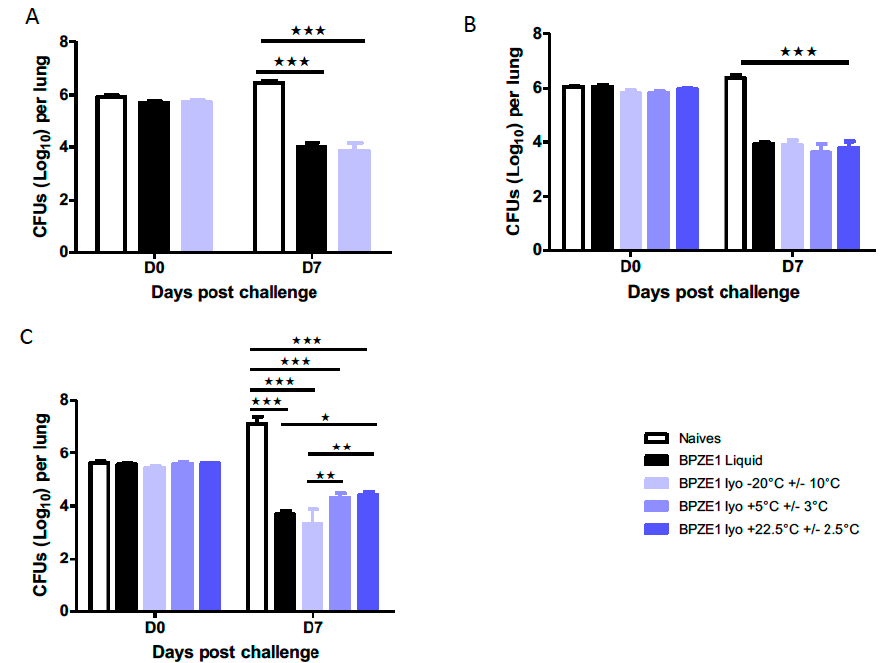
Figure 5. Potency of the lyophilized BPZE1 drug product compared to the liquid drug product. BALB / c mice (n = 5 per group and per time point) were intranasally vaccinated with 10 5 CFU of the liquid BPZE1 drug product (black bars) or the reconstituted lyophilized BPZE1 drug product (blue bars), or received PBS as a mock control (white bars). Four weeks later, the mice were challenged intranasally with 10 6 CFU of virulent BPBCTA1. CFU counts in the lungs were conducted 3 h (D0) and 7 days (D7) post-challenge. ( A ) Comparison of the potency of the liquid BPZE1 drug product with that of the lyophilized BPZE1 drug product reconstituted and administered immediately after lyophilization. ( B ) Comparison of potency of the liquid BPZE1 drug product with that of the lyophilized BPZE1 drug product reconstituted 6 months after storage at − 20 ◦ C ± 10 ◦ C (light blue lines), 5 ◦ C ± 3 ◦ C (middle blue lines) or 22.5 ◦ C ± 2.5 ◦ C (dark blue lines). ( C ) Comparison of the potency of the liquid BPZE1 drug product with that of the lyophilized BPZE1 drug product reconstituted 24 months after storage at − 20 ◦ C ± 10 ◦ C (light blue lines), 5 ◦ C ± 3 ◦ C (middle blue lines) or 22.5 ◦ C ± 2.5 ◦ C (dark blue lines). The results are expressed as means +/ – SEM. *, p < 0.05; **, p < 0.01; ***, p < 0.005.